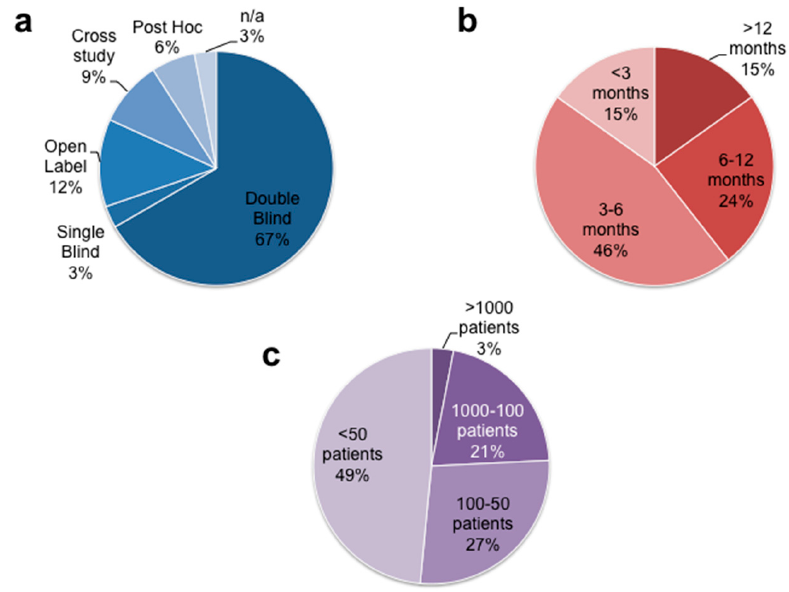
Figure 1. Pie charts for a comprehensive and general overview concerning features of 33 included studies: ( a ) study type; ( b ) duration; ( c ) size.